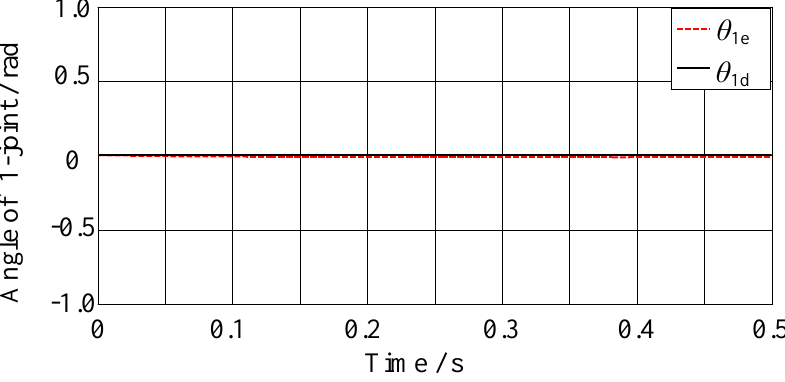
Figure 10. The desired and actual angular displacements of the